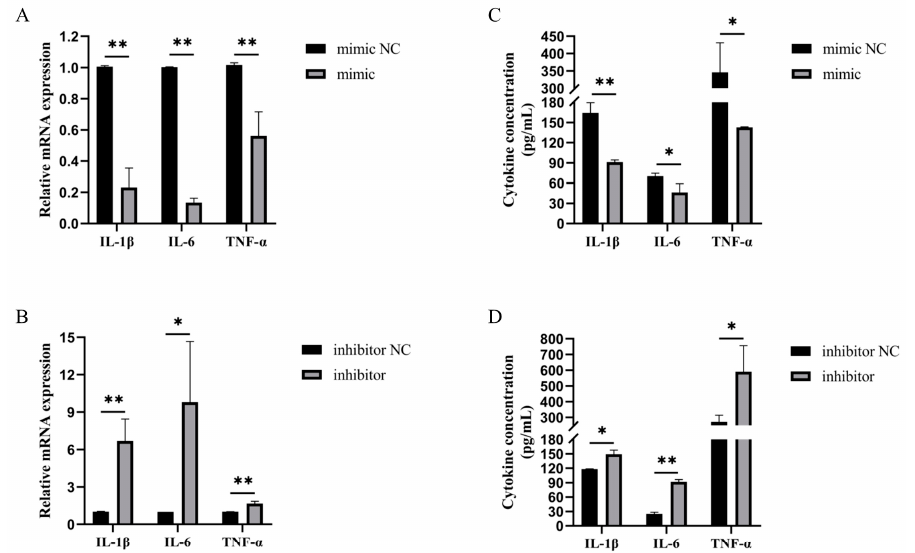
Figure 3. Bta-miR-199a-3p inhibits the production of inflammatory factors in the LPS-induced MAC-T cells. ( A , B ) The cells were transfected with the bta-miR-199a-3p mimic or inhibitor for 42 h and then induced with 50 ng/ µ L of LPS for 6 h, and qRT-PCR was used to detect the inflammatory cytokines IL-1 β , IL-6, and TNF- α . The GAPDH and RPS18 genes were used as the internal controls. ( C , D ) The protein levels of the cytokines IL-1 β , IL-6, and TNF- α were determined using ELISA. * refers to p < 0.05, ** refers to p <